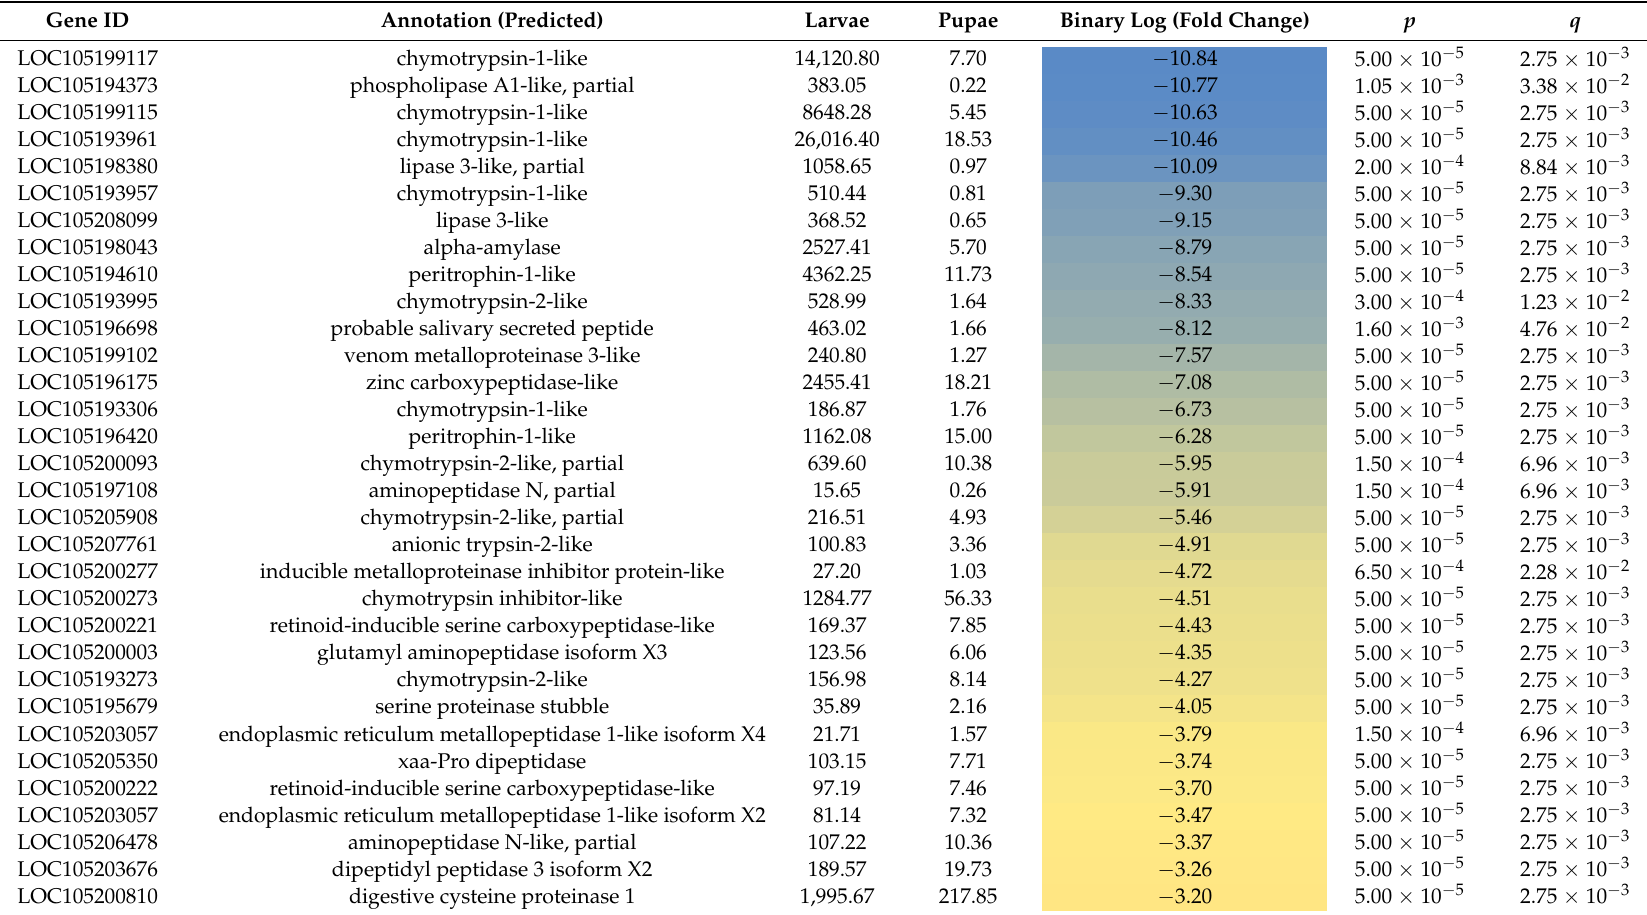
Table 4. Differentially expressed transcripts likely to be associated with digestion. Larvae and pupae values are measured in averaged FPKM. q is corrected for multiple comparisons. Negative numbers, shaded in blue fading to yellow, represent upregulation in larvae; positive numbers, shaded orange to red, represent upregulation in